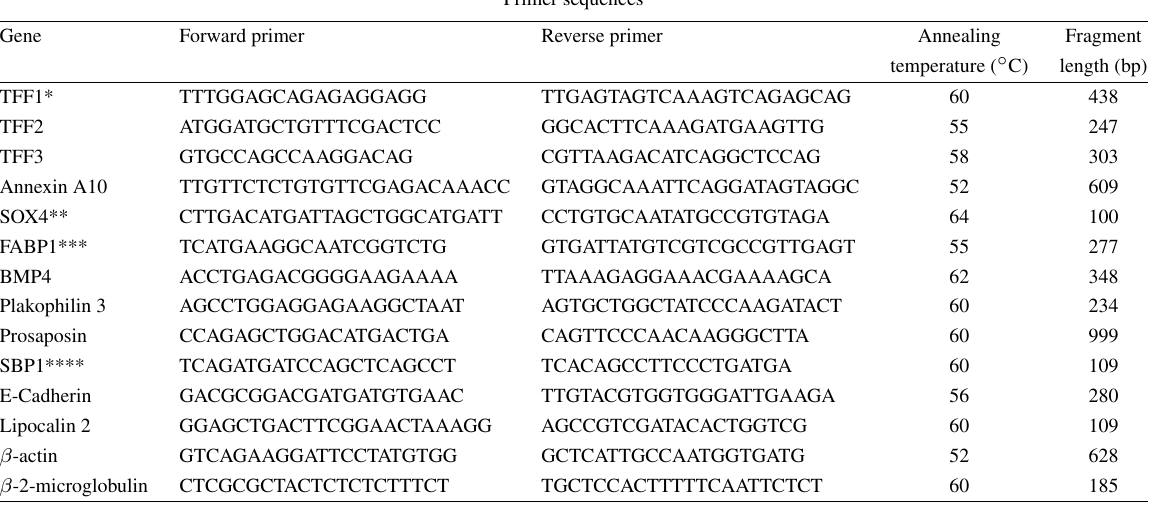
Primer sequences